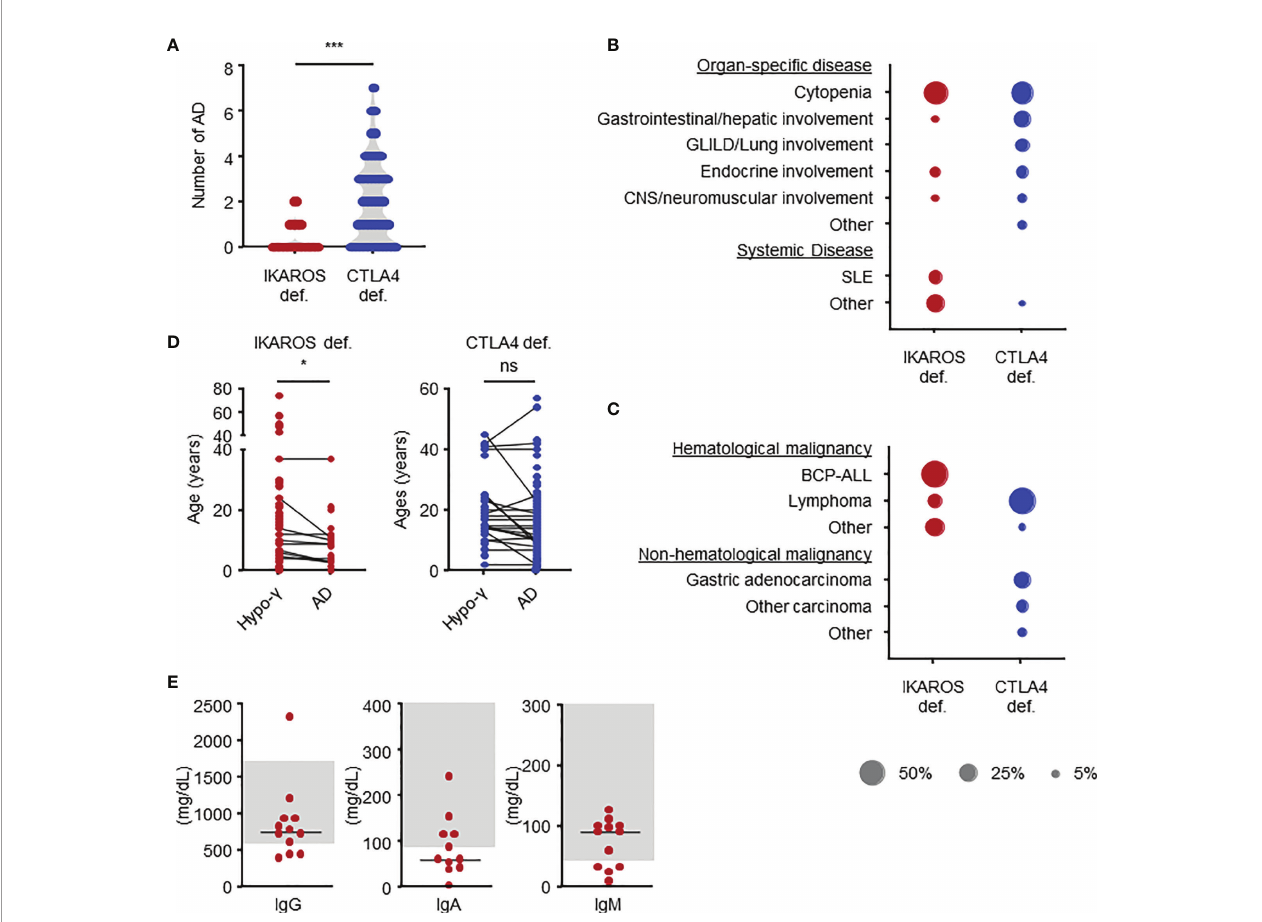
FIGURE 2 | Clinical manifestations in IKAROS and CTLA4 de fi ciencies as determined by systemic literature reviews. (A) Number of autoimmune diseases. (B) Types of autoimmune diseases in terms of percentage of total number. (C) Types of malignancies. (D) Comparison of age at the onset. (E) Serum immunoglobulin levels at the onset of autoimmune disease in patients with IKAROS de fi ciency. The groups were compared using Mann-Whitney U -test in (A) and Wilcoxon signed-rank test (D) . * P < 0.05, *** P < 0.001. AD, autoimmune disease; BCP-ALL, B-cell precursor acute lymphoblastic leukemia; hypo- g , hypogammaglobulinemia; ns, not signi fi cant; SLE, systemic lupus